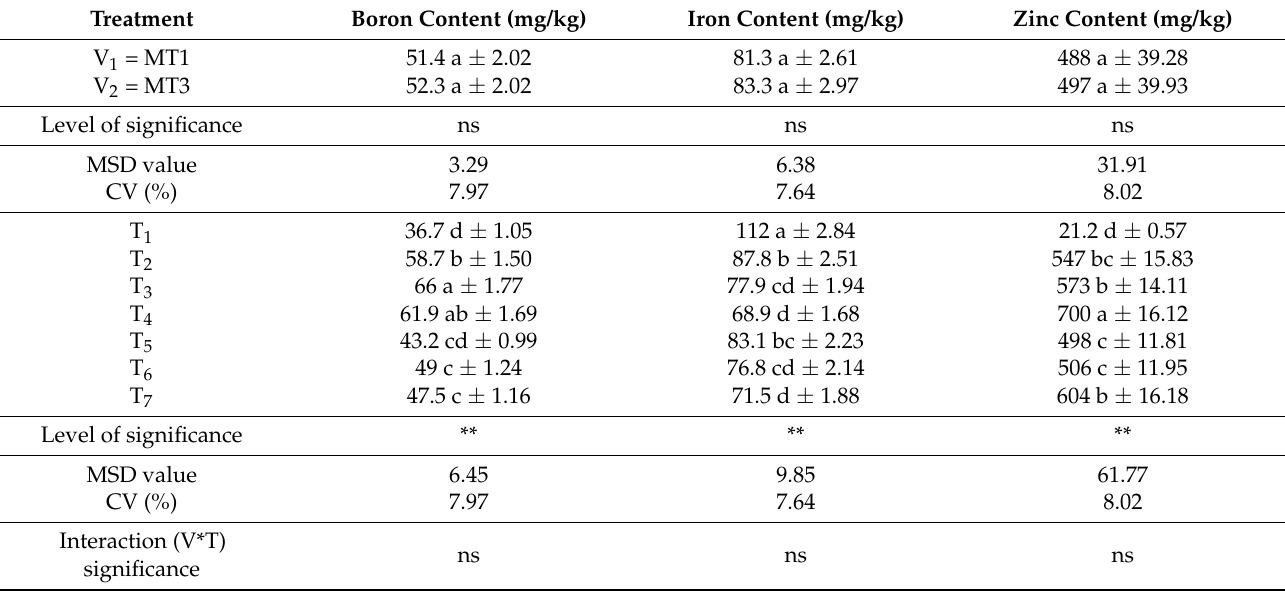
Table 8. Effect of zinc fertilizer and zinc oxide nanoparticles on boron, iron, and zinc content in leaves of two selected tomatoes